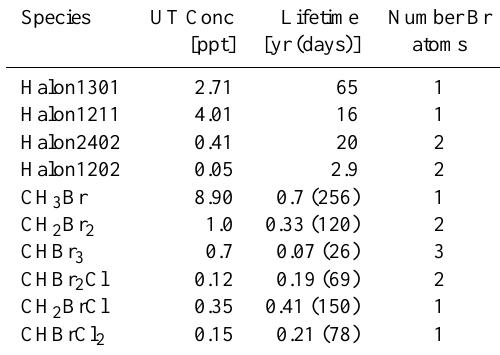
Table 1. Br y contributing organic source gases initialized for the base of the TTL 2 = 365K. Halons and CH 3 Br as prescribed from WMO (2006, Table 8–5) for year 2000 and VSLS species as given by the upper limit of the observed range (WMO, 2006, Table 2–2). Lifetimes from WMO (2006, Table